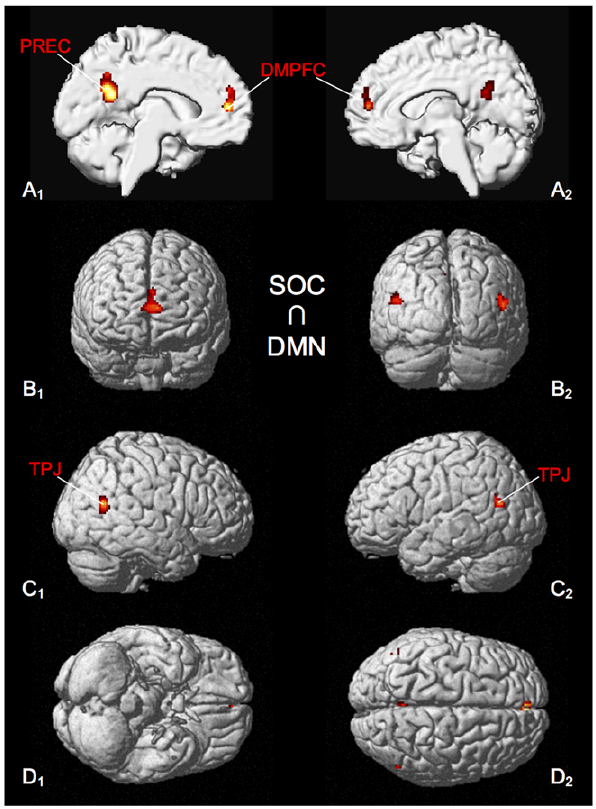
Figure 5. Significant results of the conjunction analysis of SOC > DMN. All results are displayed on the left and right lateral surface view, the anterior/posterior and dorsal/ventral view of the MNI single subject template. DMPFC: dorso-medial prefrontal cortex, PREC: precuneus, TPJ: temporo-parietal junction. doi:10.1371/journal.pone.0030920.g005 PLoS ONE |